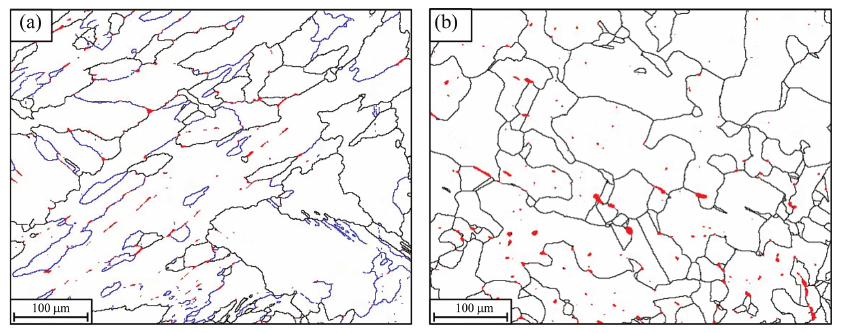
Figure 11: Phase composition for the tensile samples deformed at (a) 700°C and (b) 800°C with